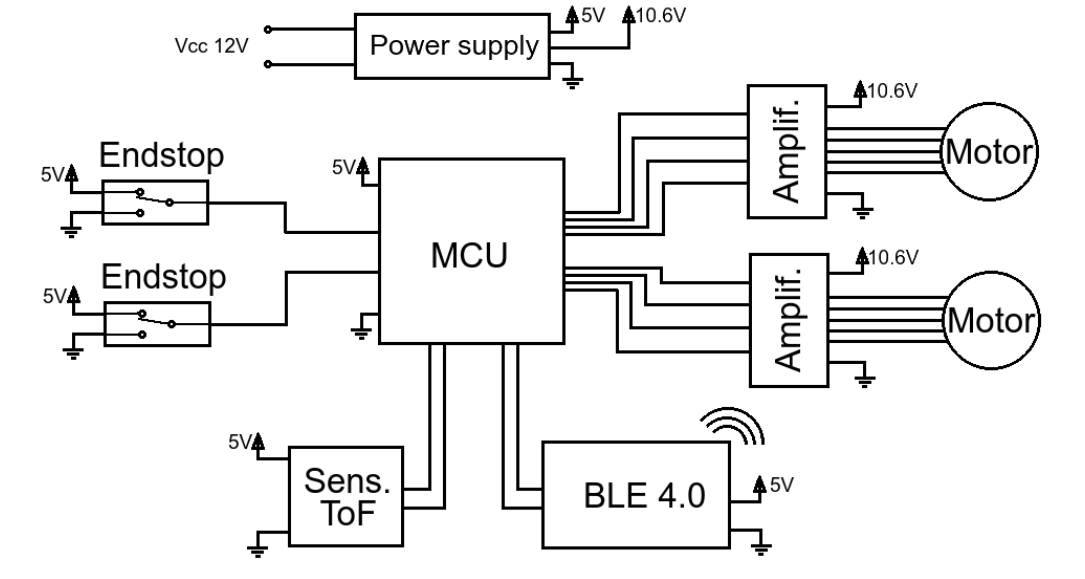
Figure 2. Electrical system general